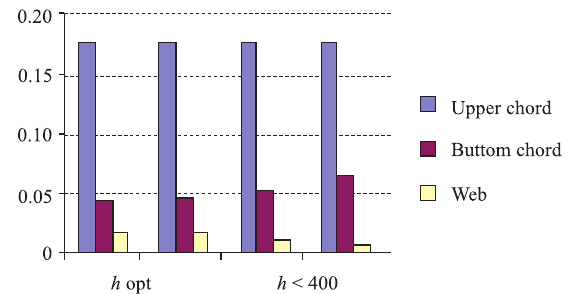
Fig. 11. Comparison of steel expenditures in m 3 for different truss height cases